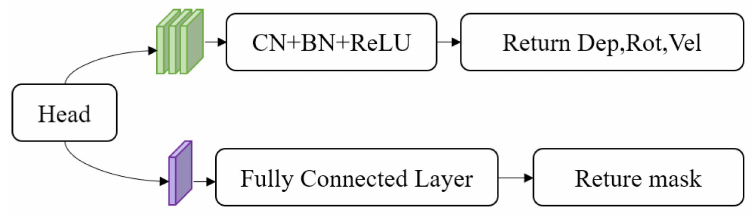
Figure 12. The head network